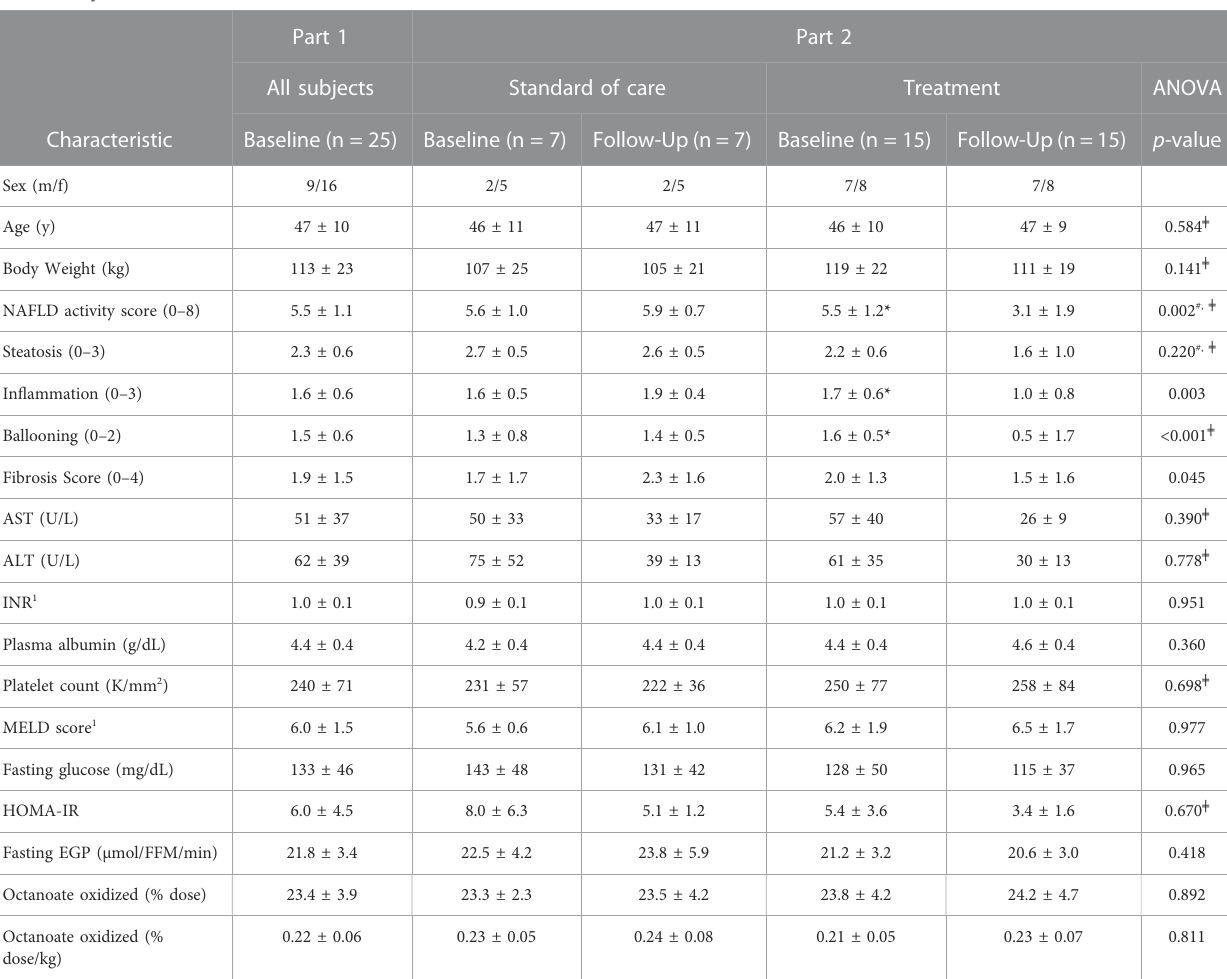
TABLE 1 Subject